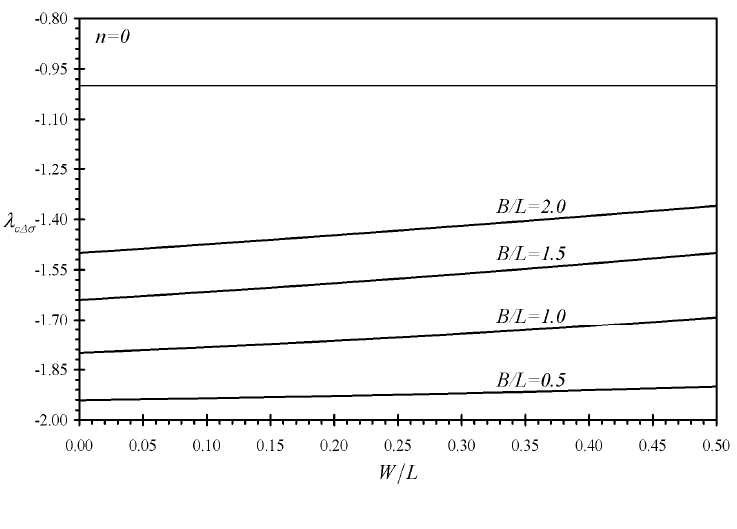
Figure 8. Effects of the relative dimensions of the microcantilevers assemblies (b) and (c) on the second performance indicators λ c Δσ